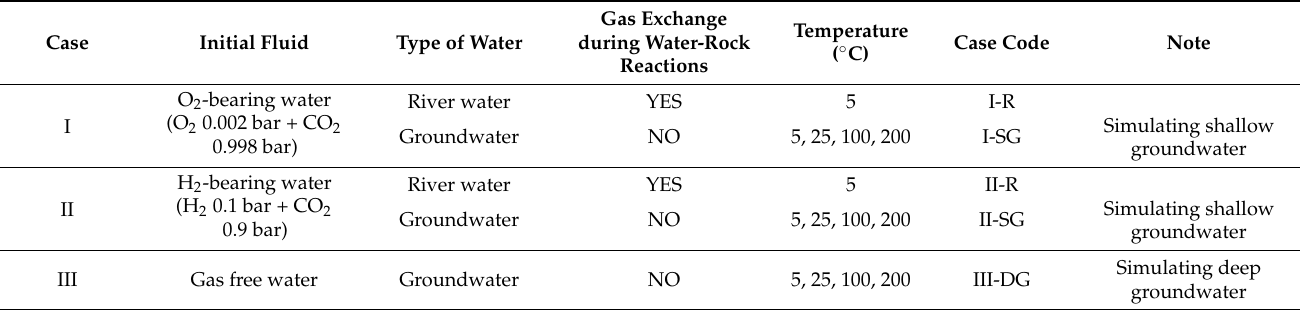
Table 2. Initial fluid parameters used in the thermodynamic modeling. Two types of initial fluids (Case I-R, and II-R) are considered for river water, whereas three types of fluids (Case I-SG, II-SG, and III-DG) are considered for groundwater.